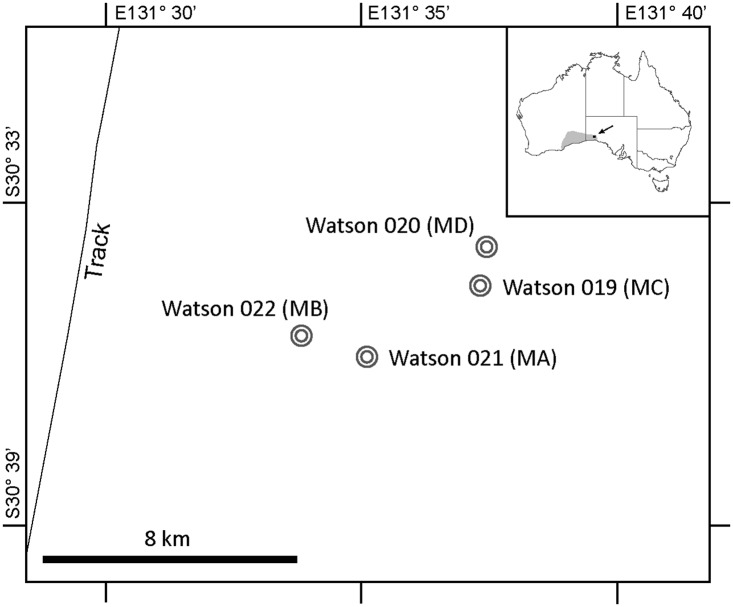
Nullarbor Plain Map. This figure shows the Watson location in the Nullarbor Plain, Australia. Circles indicate the locations from which the four meteorites and associated soils were collected.